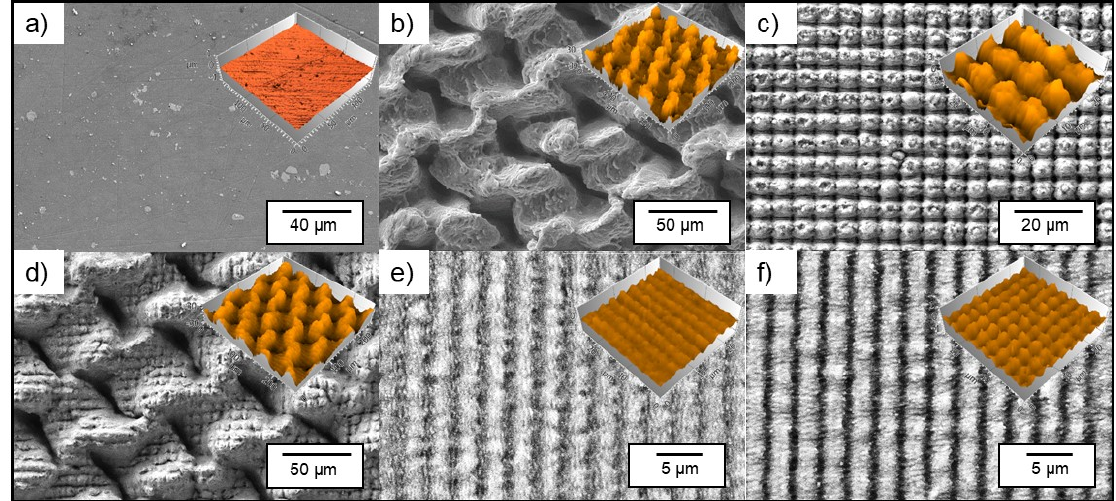
Figure 3. Scanning electron microscope images of ( a ) an untextured reference and of microstructures fabricated with ( b ) DLW for a 50 µm mesh-like structure using a laser fluence of 1.06 J/cm 2 , a scanning speed of 250 mm/s at a repetition rate of 30 kHz; ( c ) DLIP for a 7.0 µm pillar-like structure using a laser fluence of 1.93 J/cm 2 , a pulse-to-pulse overlap of 99% at a repetition rate of 10 kHz; ( d ) a combination of DLW and 7.0 µm DLIP for a multiscale structure; ( e ) DLIP for a 2.6 µm line-like structure and ( f ) DLIP for 2.6 µm cross-like structure using the same fluence, repetition rate, and overlap as for the 7.0 µm DLIP structures. The inserted confocal images provide an impression of the topography. The laser parameters are provided in the experimental section.